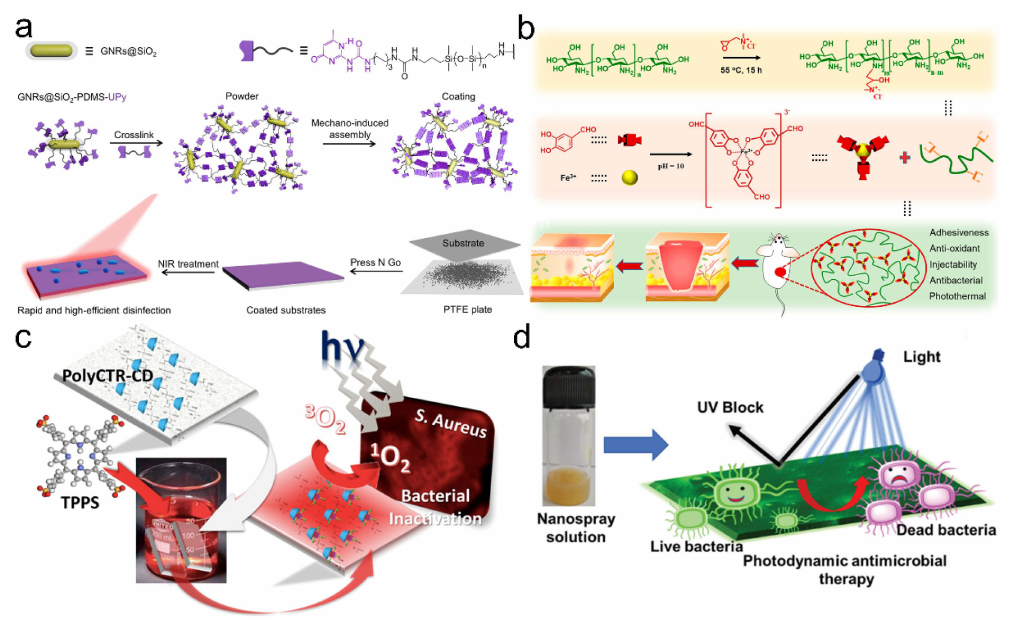
Figure 4. ( a ) A supramolecular nanocomposite adhesive coating was mechano-induced assembled from powders, showing rapid and remarkable photothermal disinfection effectiveness upon NIR irradiation. Reproduced with permission [50]. Copyright 2021, American Chemical Society. ( b ) A dynamically crosslinked antimicrobial adhesive hydrogel in which the quaternized chitosan provided the inherent antimicrobial ability and catechol-Fe with NIR properties contributed to the photo- responsive antimicrobial capability. Reproduced with permission [51]. Copyright 2021, American Chemical Society. ( c ) Antimicrobial polypropylene fabrics assembled by host-guest interactions possess sustained release of photosensitizers and efficient photodynamic antimicrobial activity to Gram-positive S. aureus and Gram-negative P. aeruginosa. Reproduced with permission [53]. Copyright 2017, American Chemical Society. ( d ) Schematic representation of the UV blocking and antimicrobial photodynamic activity using the coating. Reproduced with permission [54]. Copyright 2021, Royal Society of